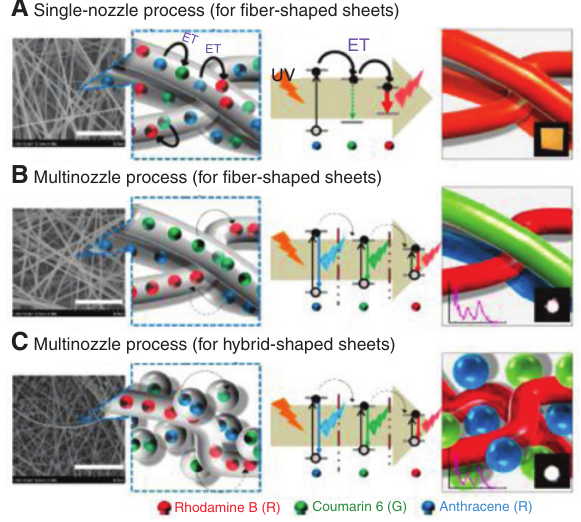
Figure 12: Fluorescent optical micrographs of the identical PS/ F8BT ES fiber excited with light in the direction of the corresponding white arrow. Emission is observed to be dependent on the direction of polarization. (Reprinted with permission from Yang et al. ACS Nano, 6, 622, © 2012 American Chemical